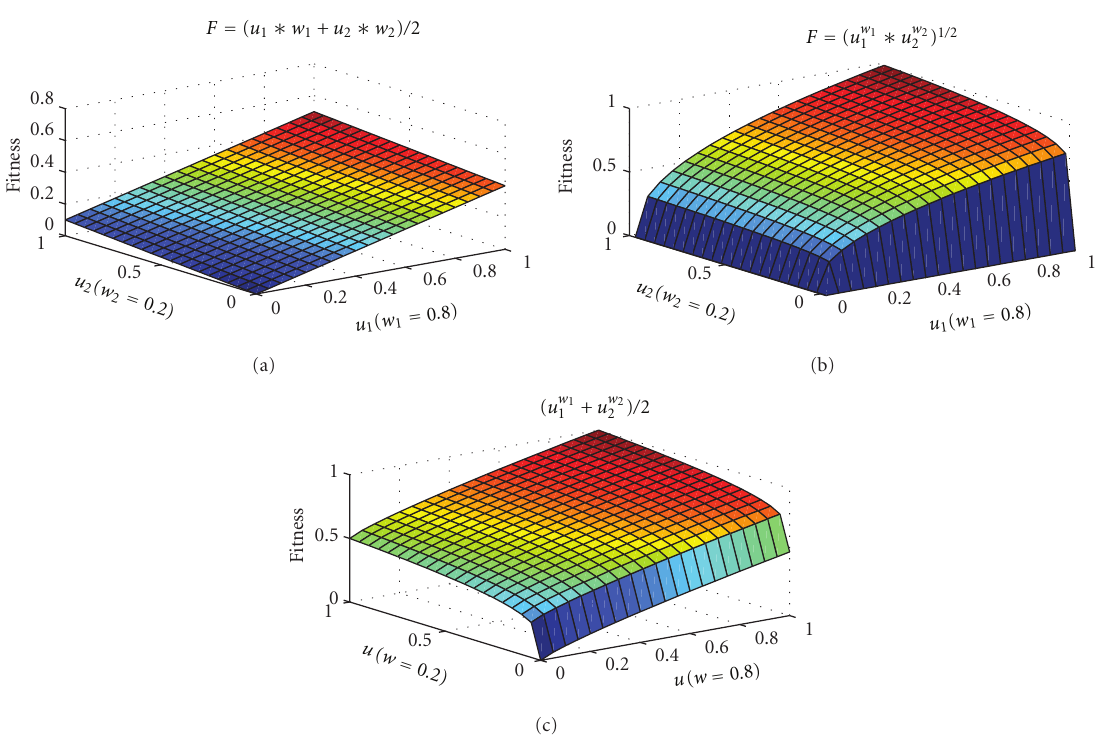
Figure 3: Fitness space— three methods for calculating overall fitness from utilities and weights were considered. These figures show the fitness with w 1 = 0 . 8 and w 2 = 0 . 2. The goal is for fitness to only be close to one, or highly desirable, when all of the utilities are also closer to 1. If anyone utility value’s desirability drops, then the overall fitness value should drop as well. The product method met these criteria